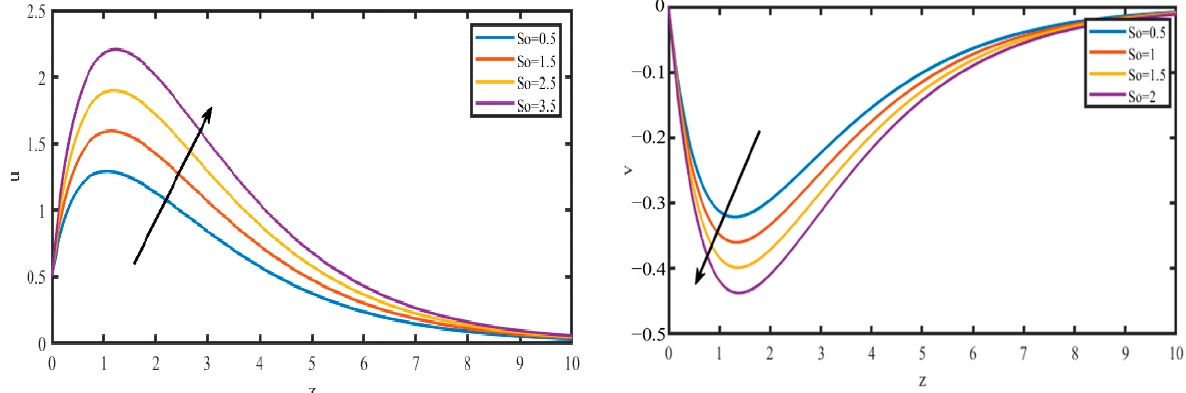
Figure 8. The velocity patterns for u and v plotted vs. F , with k = 0.50, R = 1.0, Gr = 5.0, S = 1.0, Gm = 3.0, m = 0.20, Pr = 0.710, H = 1.0, Sc = 0.220, Kc = 1.0, n = 0.50, t = 0.50, So = 0.50, M = 2.0.